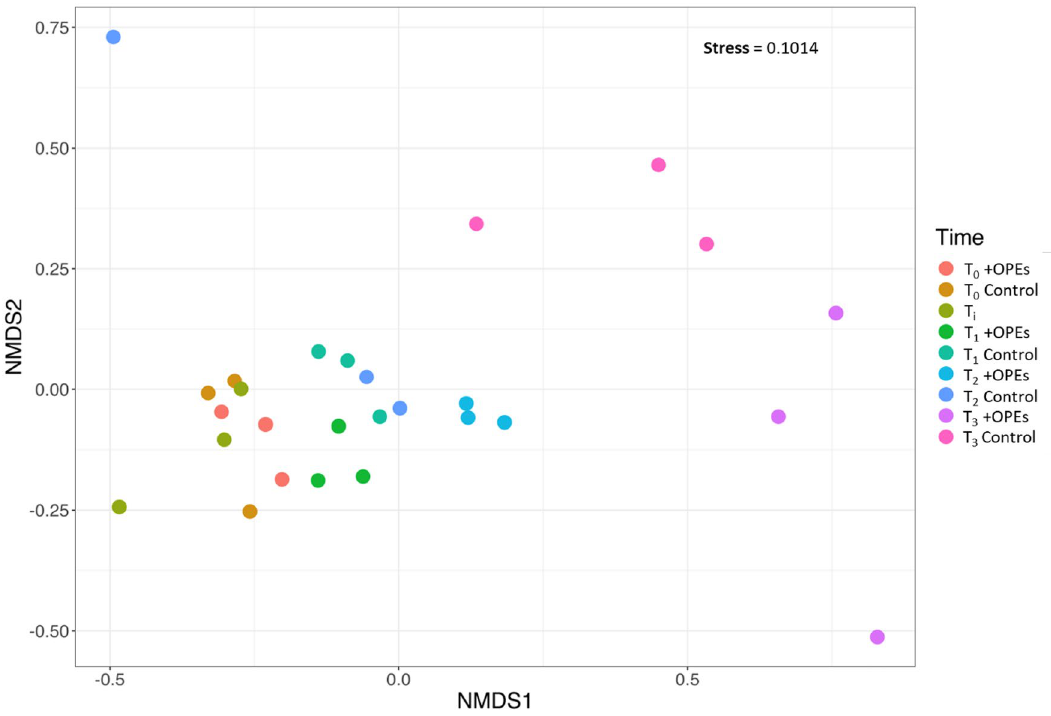
Figure 5. NMDS ordination for dissimilarities in the microbial community distribution at the different sampling times (beginning of the incubation T0 and after 7 (T1), 14 (T2) and 30 (T3) days) based on Bray– Curtis distances. Control, uncontaminated sediments; Ti, undisturbed sediments at time of sampling; + OPEs, OPEs contaminated